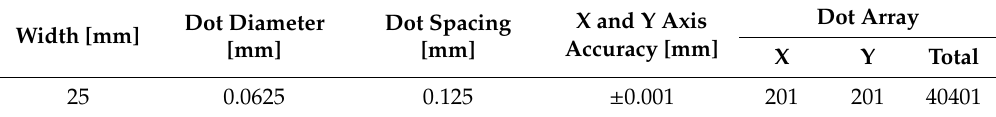
Figure 2. Illustration of the standard artefact of the dot grid target. Table 1. Detailed information about the dot grid target standard artefact.